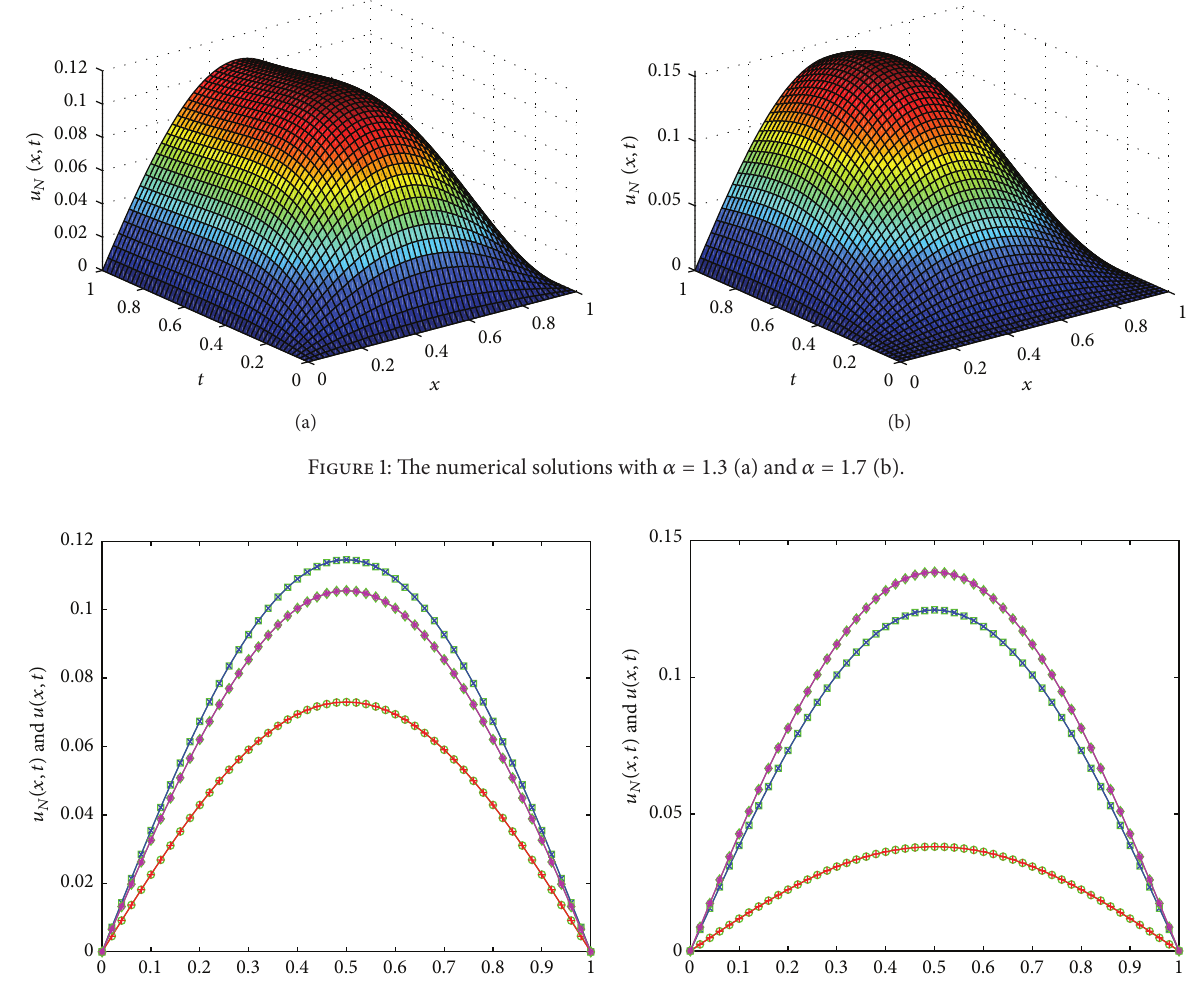
diagrams of the numerical solutions 𝑢 𝑁 (𝑥, 𝑡) on the whole computational domain [0, 1] × [0, 1] with 𝜏 = 0.001, 𝑛 = 20